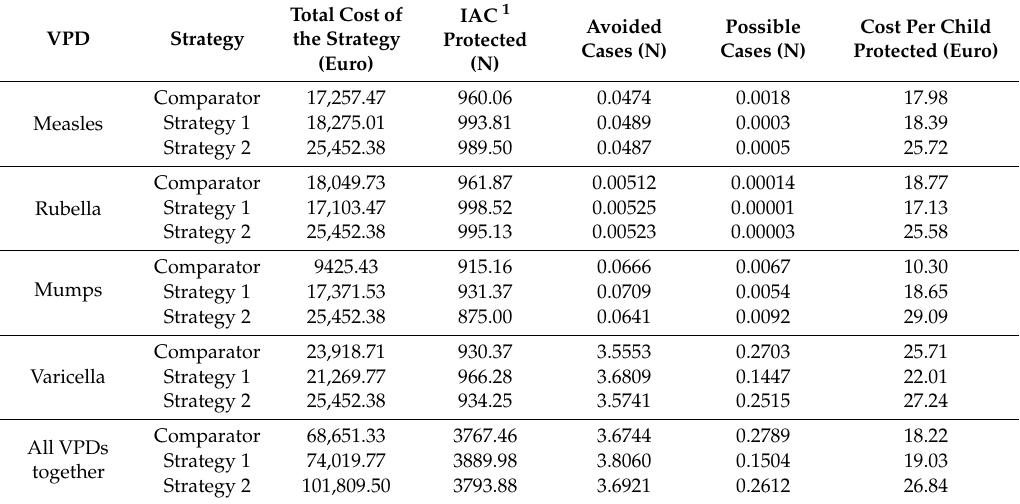
Table A3. Clinical and economic outcomes per 1000 internationally adopted children (IAC) excluding children < 1 year of age (ELISA serotesting).